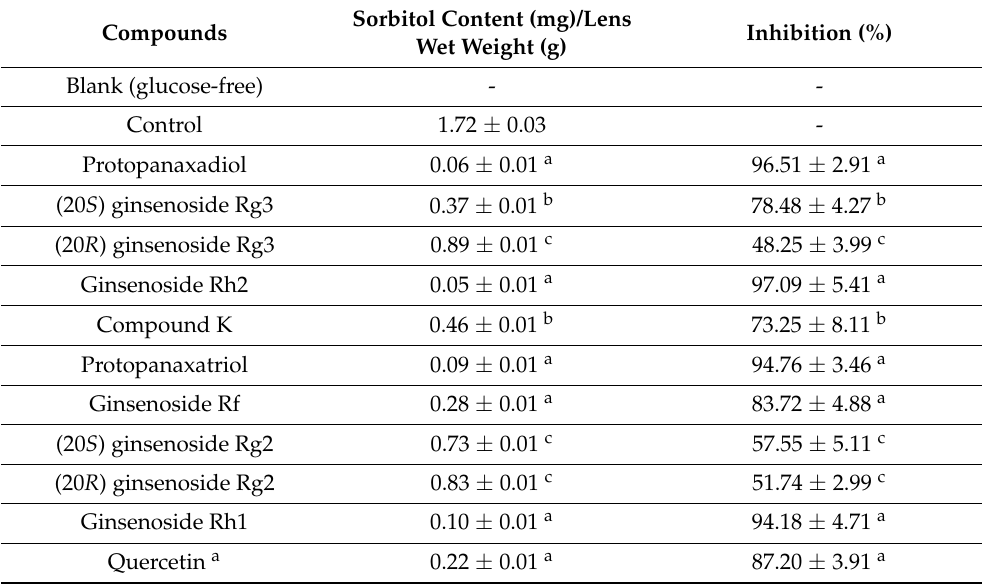
0.22 ± 0.01 a 87.20 ± 3.91